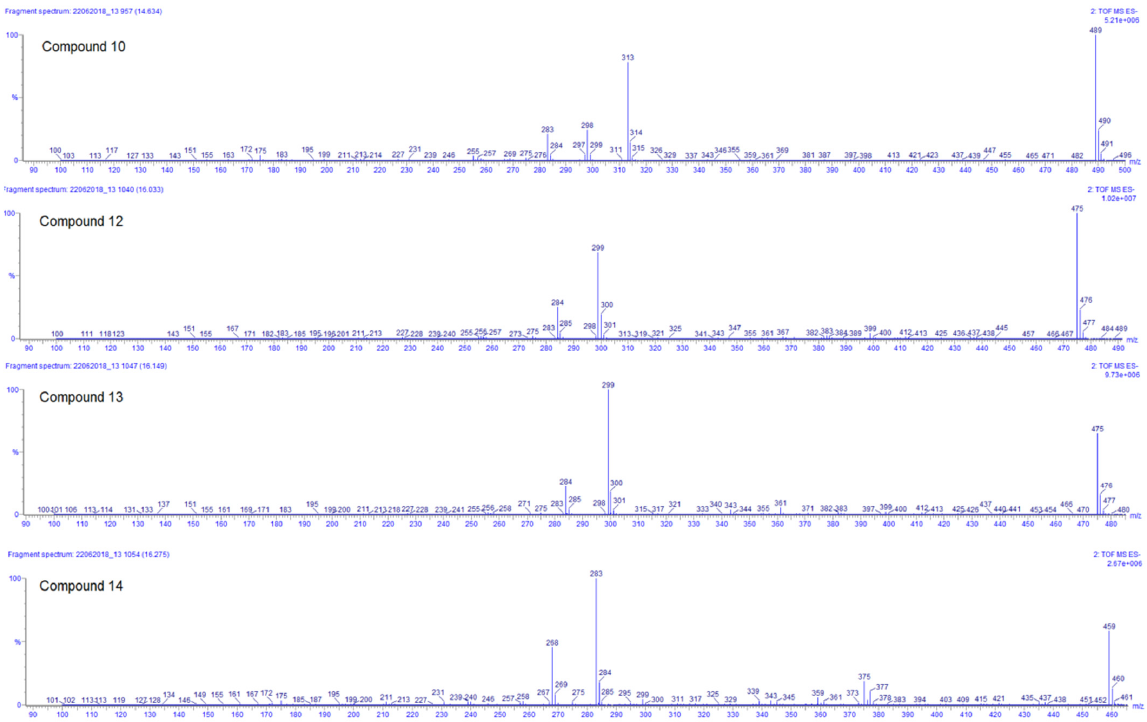
Figure 5. ESI negative ion mode MS 2 spectra of compounds 10 , 12 , 13 , and 14 of Plectranthus neochilus extracts.